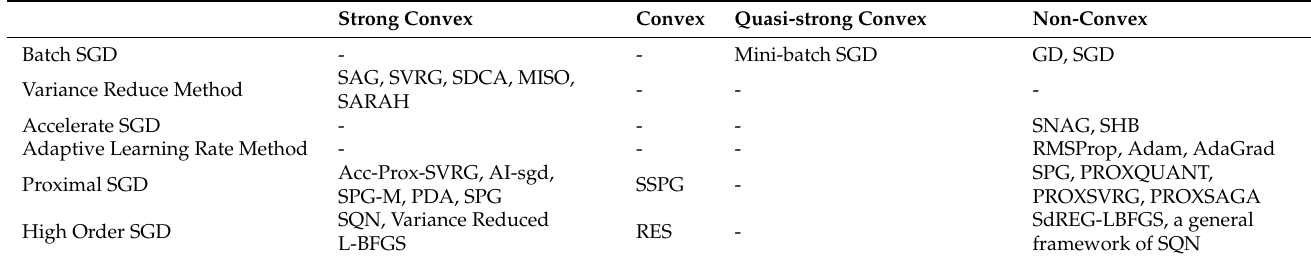
Table 9. The convergence of stochastic methods under different